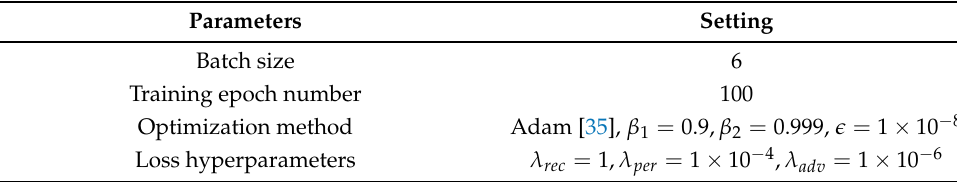
Table 2. Parameter setting during the training process. Parameters Setting